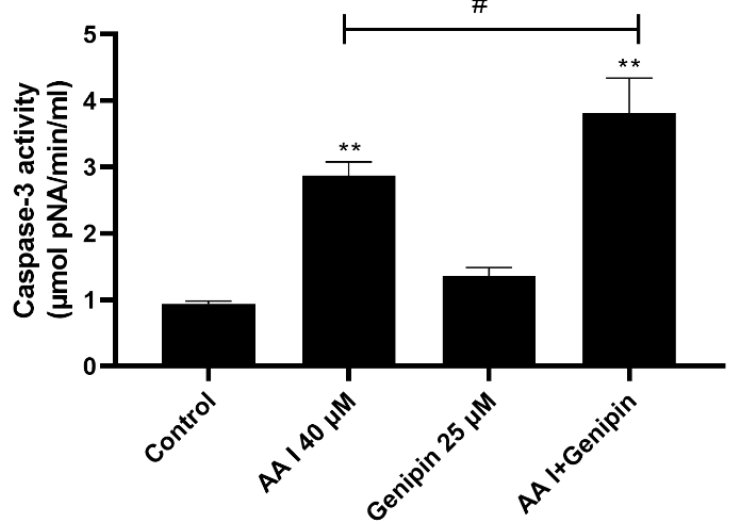
Figure 3. The activity of caspase-3 was determined by caspase activity assays kits after treatment with 40 µ M AA I or 25 µ M genipin for 24 h. All the experiments were repeated at least three times, and the data were expressed as means ± SD (** p < 0.01 vs. Control group; # p < 0.05).